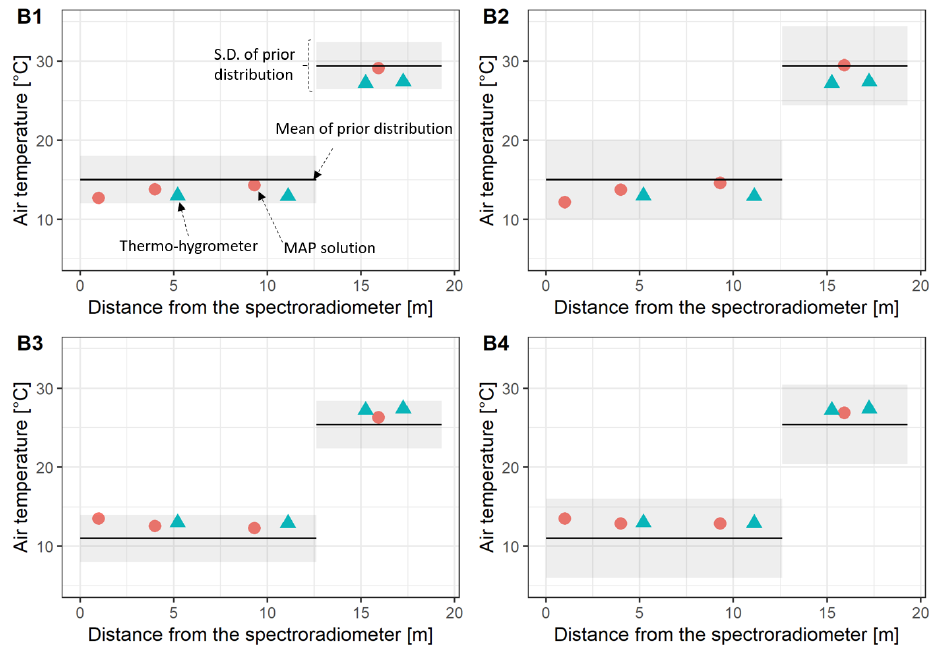
Figure 9. MAP solution in Cases ( B1 – B4 ). The solid line indicates the mean of the prior information x a given by the normal distribution. The mean of the prior information in Cases B1 and B2 were set 2°C higher, whereas those of Cases B3 and B4 were set 2°C lower than the measured value of the thermohygrometer before conducting the experiments. The shaded region represents the standard deviation of the prior information (i.e., square root of the diagonal component of S a ) set in Table